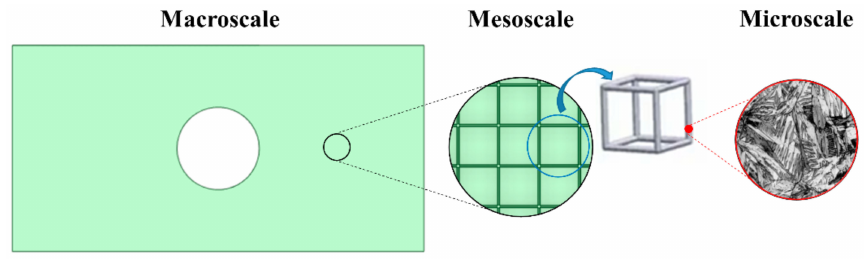
Figure 1. The macro-, meso-, and microscale structure of a hollow plate, based on